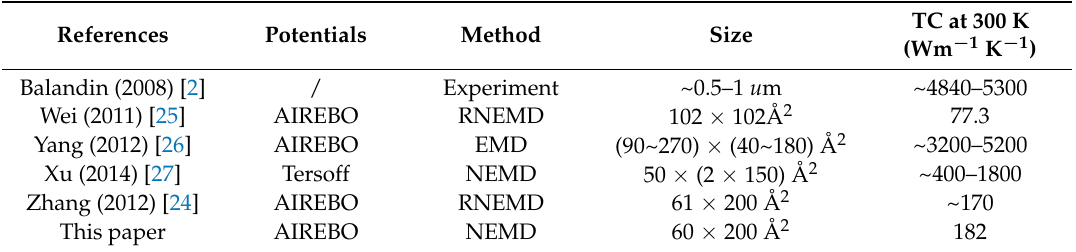
Figure 5. ( a ) Steady-state temperature profile of Gr without defect obtained using the NEMD simulations at 300 K. The color bars highlight the hot/cold bath in simulation. ( b ) Energies added to the hot bath and removed from the cold bath with respect to the time.